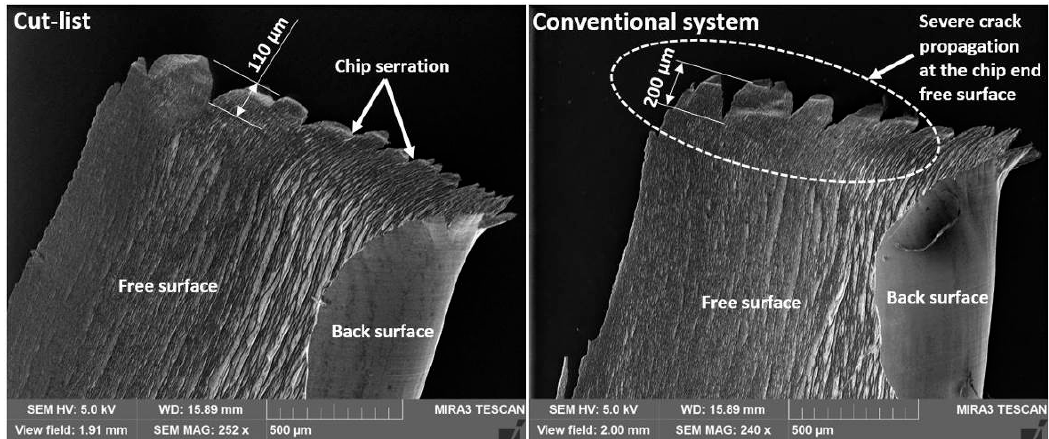
Figure 14. SEM images show serration, back and free surfaces of the chips produced at 95 m/min and 0.1 mm/rev.